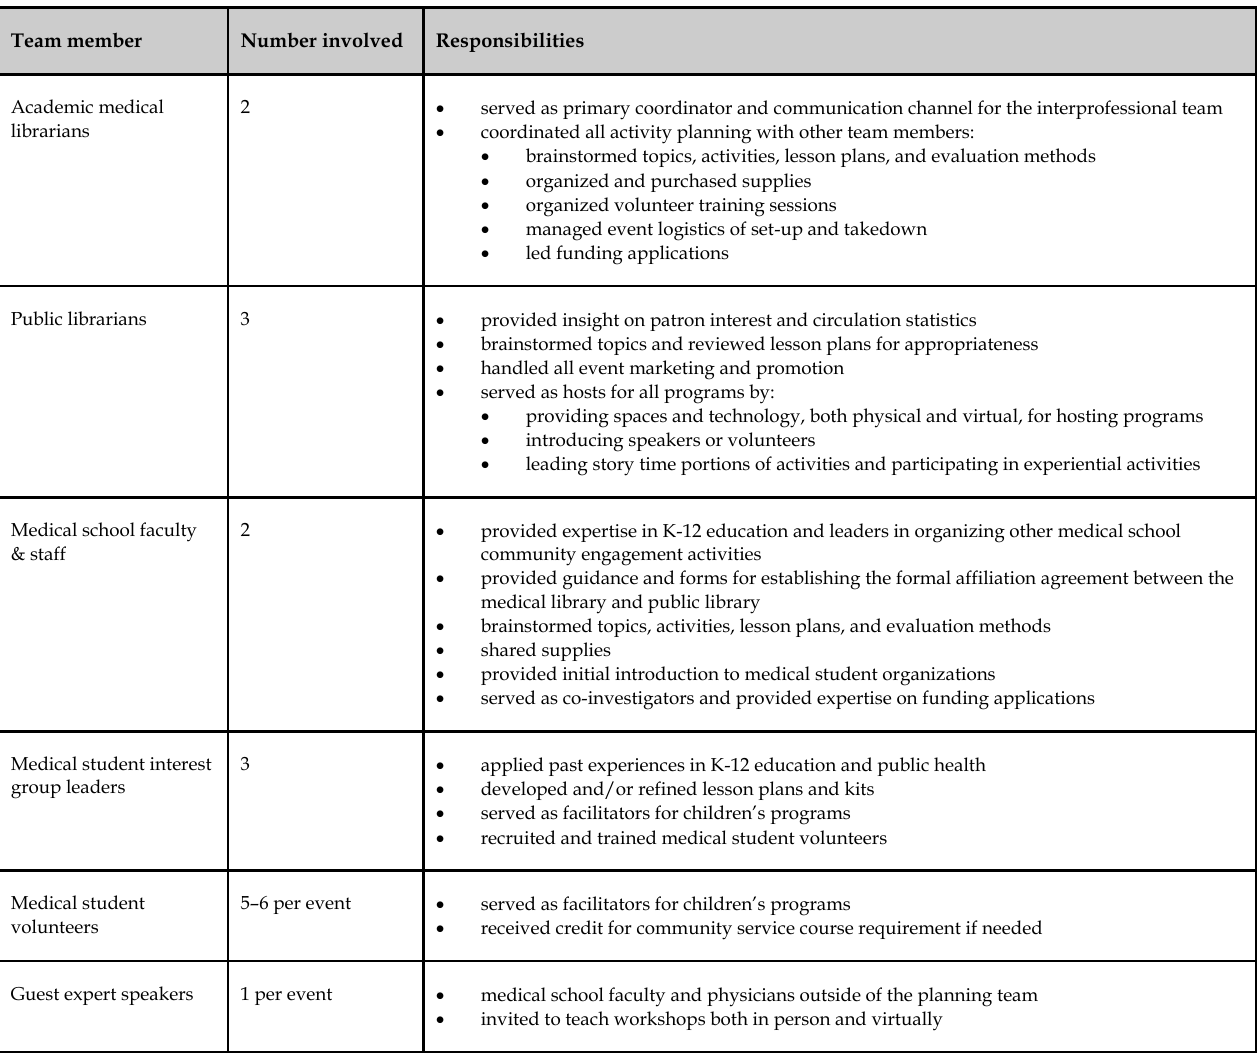
Table 2 Summary of interprofessional team roles & responsibilities Team